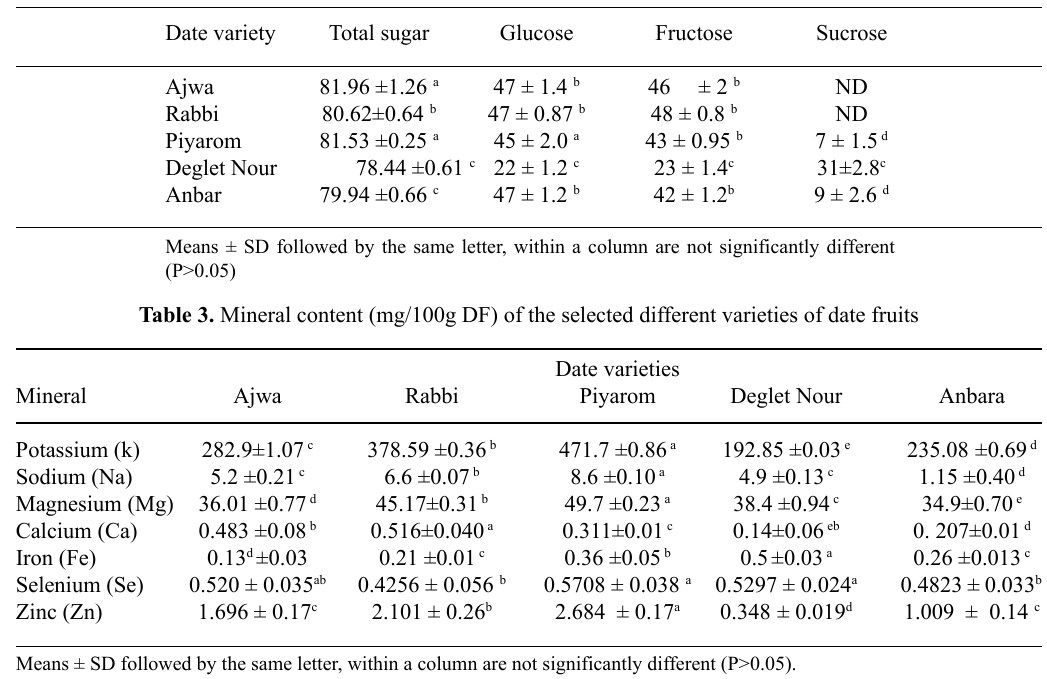
table 2. Sugars content (mg/100g DF) of the selected